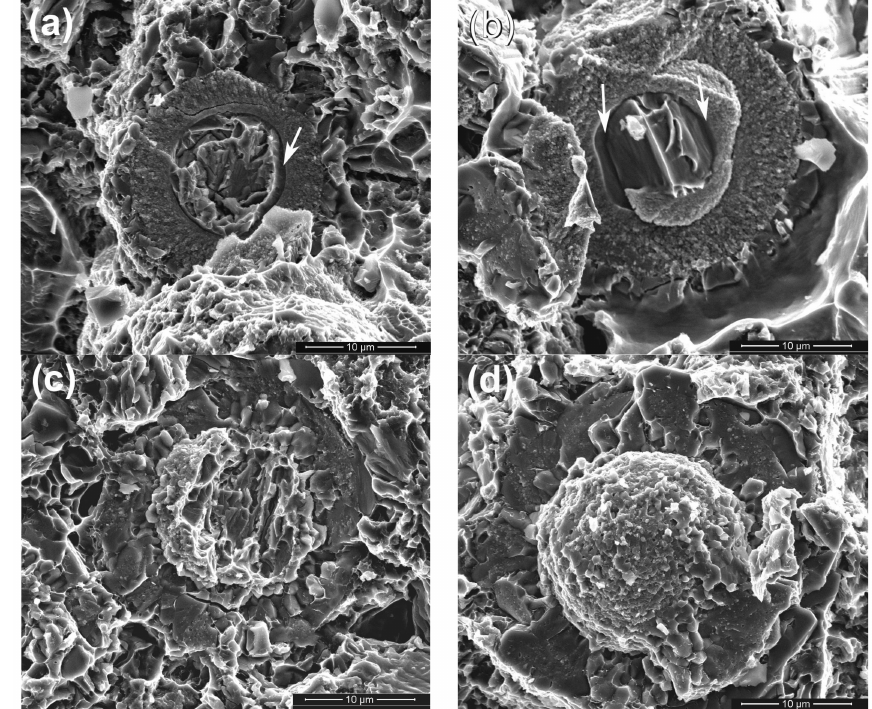
Figure 9. Morphologies of reinforcing particles on the fracture surfaces of the composites thixoformed at reheating temperatures of ( a ) 590 ◦ C, ( b ) 600 ◦ C, ( c ) 605 ◦ C, and ( d ) 610 ◦ C.